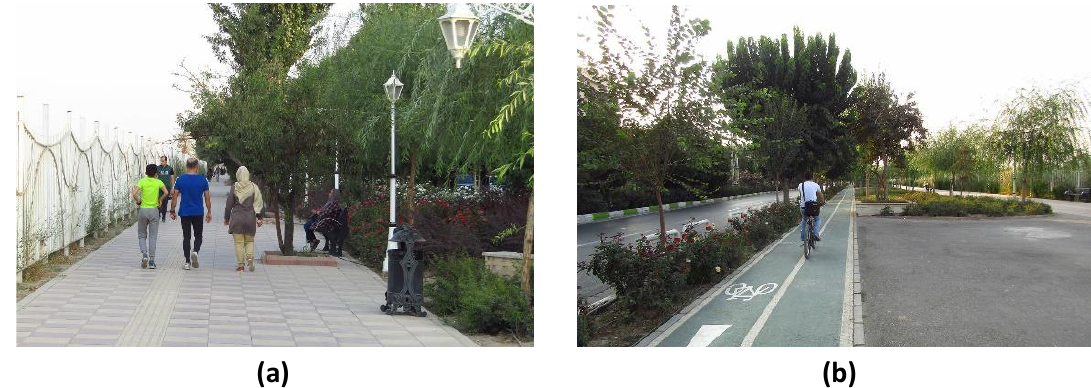
Fig. 4: (a) Main pedestrian walkway with 5m wide; (b) 2m wide bicycle path with colored and mastic asphalt pavement